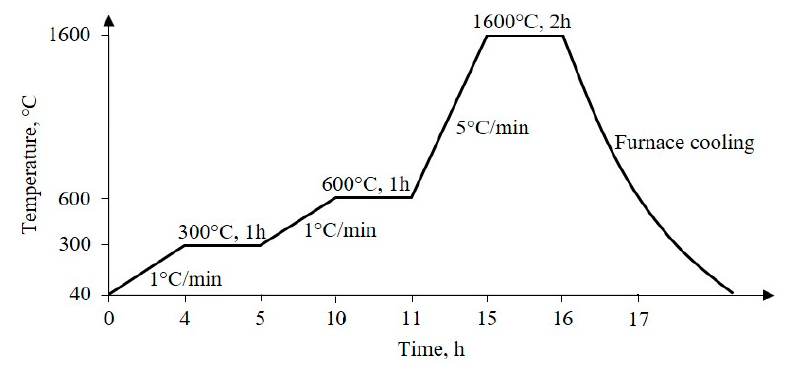
Figure 1. Scheme of sintering regime of Al 2 O 3 foam.